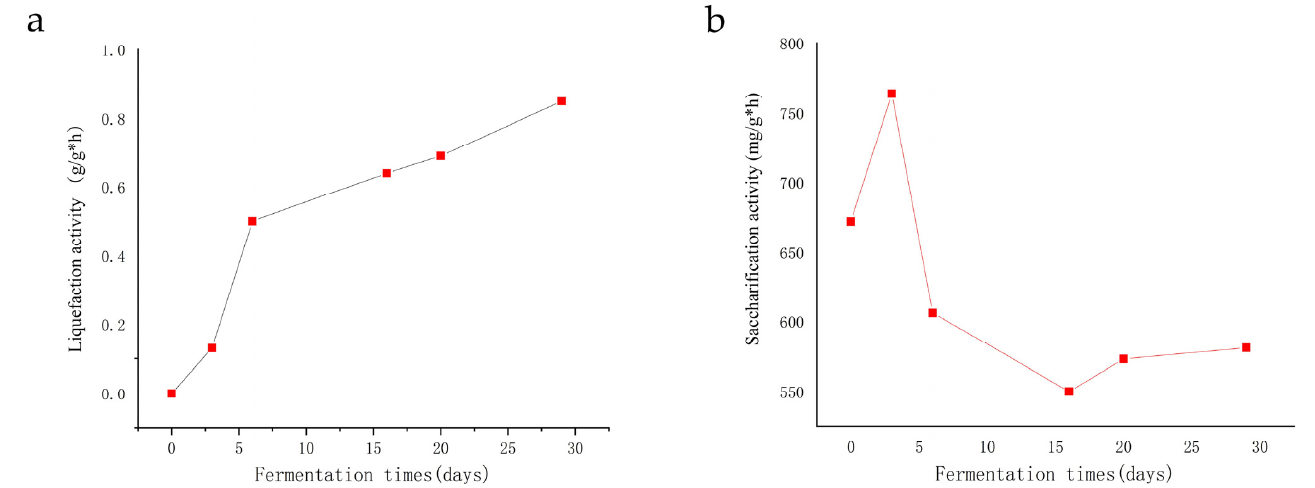
Figure 7. The evolution of saccharification activity ( a ), liquefaction activity ( b ), during Daqu fermen- tation.